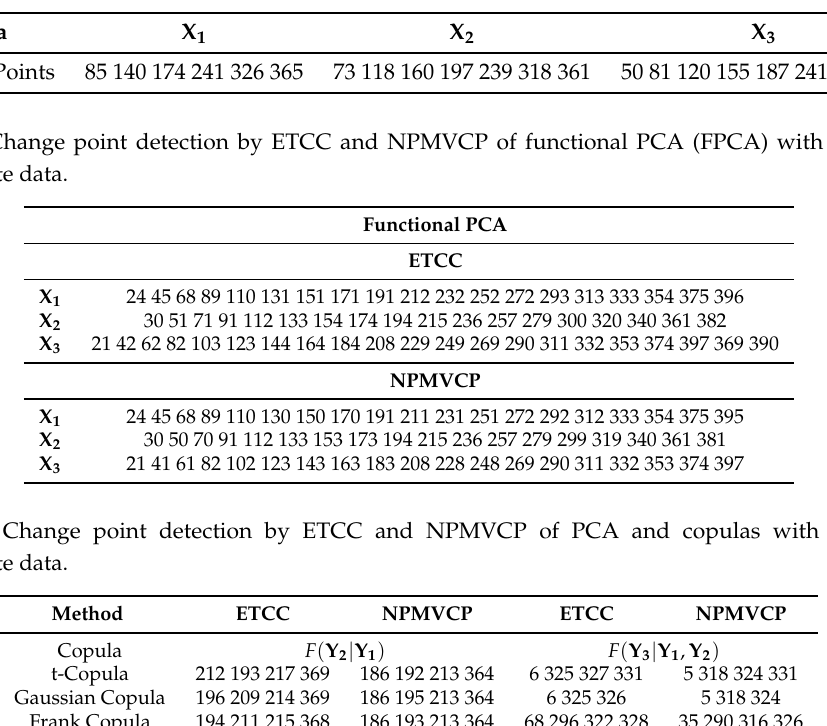
Table 6. Change point detection with the James, Zhang, and Matteson (2019) NPMVCP analysis of simulated multivariate data.